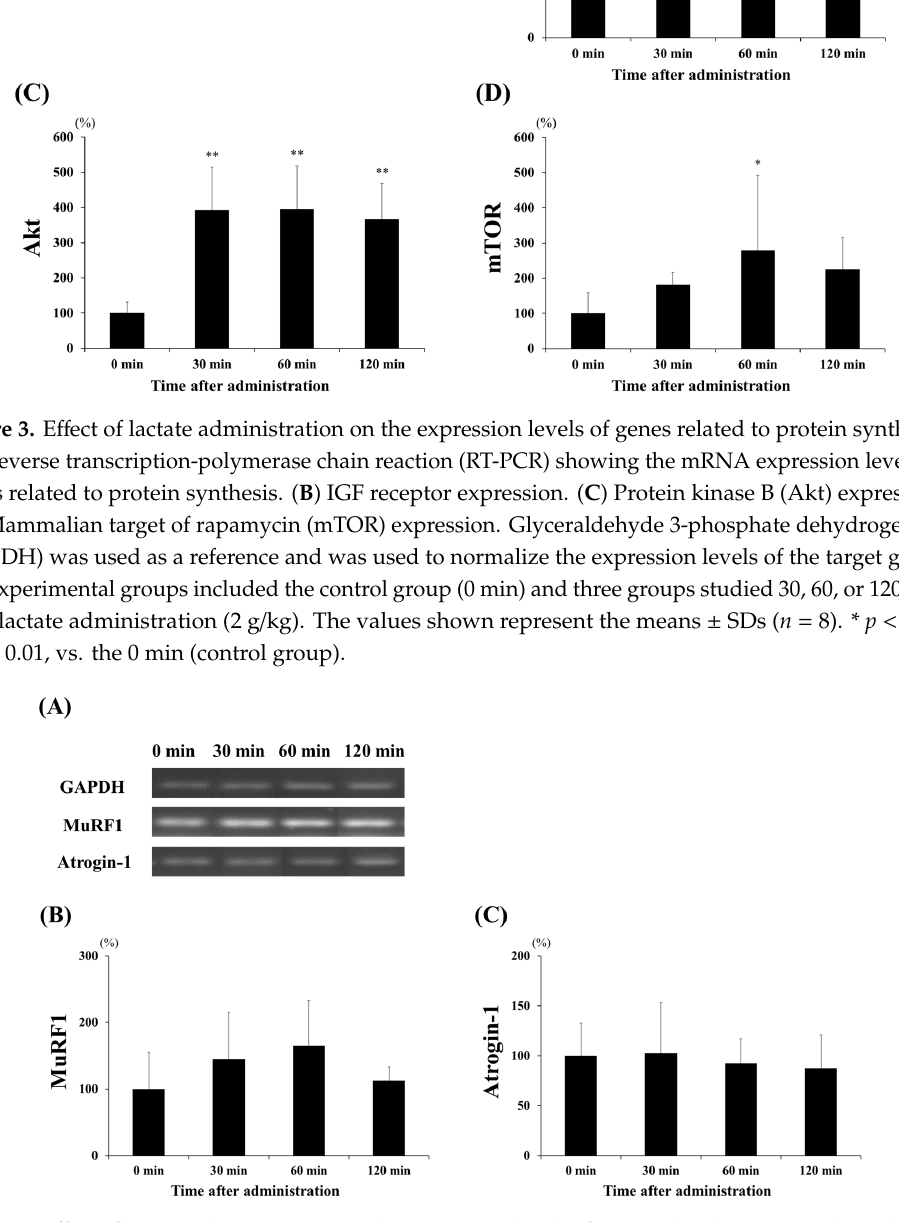
Figure 4. E ff ect of lactate administration on the expression levels of genes related to protein degradation. ( A ) Reverse transcription-polymerase chain reaction (RT-PCR) bands related to protein degradation. ( B ) Muscle RING-finger protein-1 (MuRF1) expression. ( C ) Muscle-specific F-box protein (atrogin-1) expression. Glyceraldehyde 3-phosphate dehydrogenase (GAPDH) was used as a reference mRNA and was used to normalize the expression of the target genes. The experimental groups included the control group (0 min) and three groups studied 30, 60, or 120 min after lactate administration (2 g / kg). The values shown represent the means ± SDs ( n = 8). The letters indicate significant di ff erences between the groups ( p <